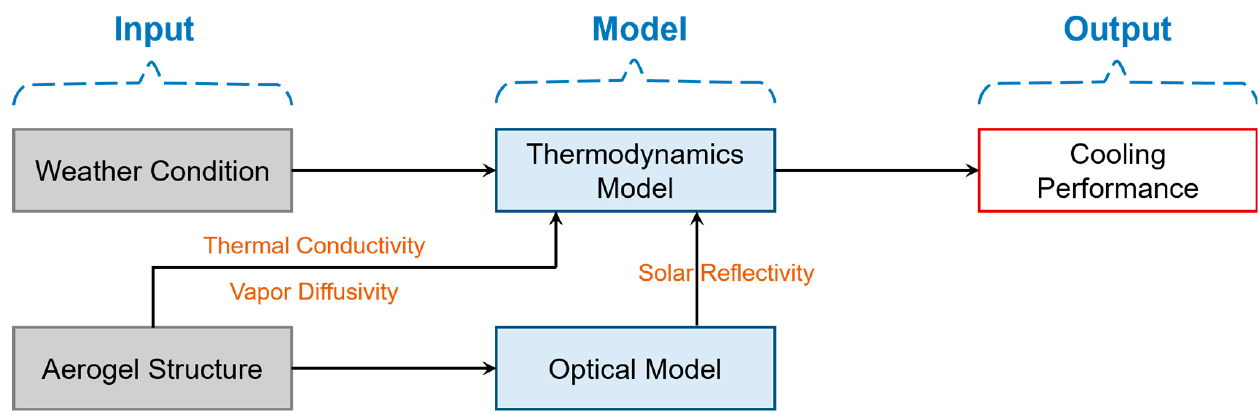
Figure 2. Schematic of the modeling process.